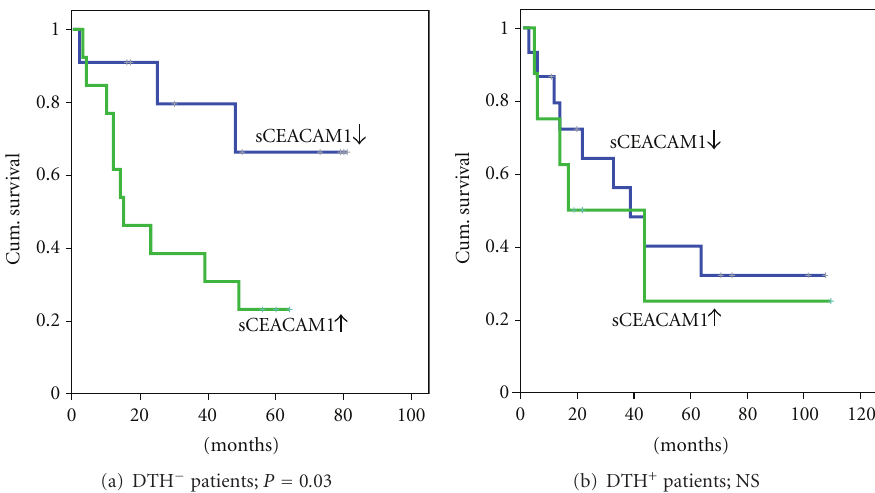
Figure 4: Monitoring of sCEACAM1 further stratifies DTH-negative patients into two prognostically distinct groups. The analysis described in Figure 3 was performed exclusively for (a) DTH-negative patients ( N = 24) and (b) DTH-positive patients ( N = 23). Subgroups sizes were N = 11 (DTH − ) or N = 15 (DTH + ) for decreased sCEACAM1 and N = 13 (DTH − ) or N = 8 (DTH + ) for increased